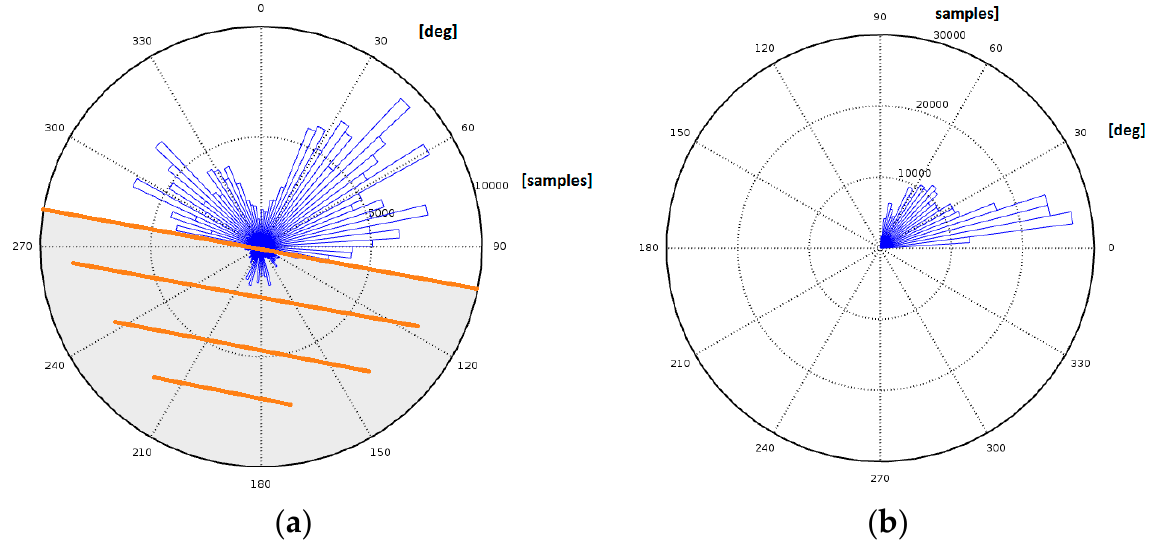
surements are presented in Figure 6.